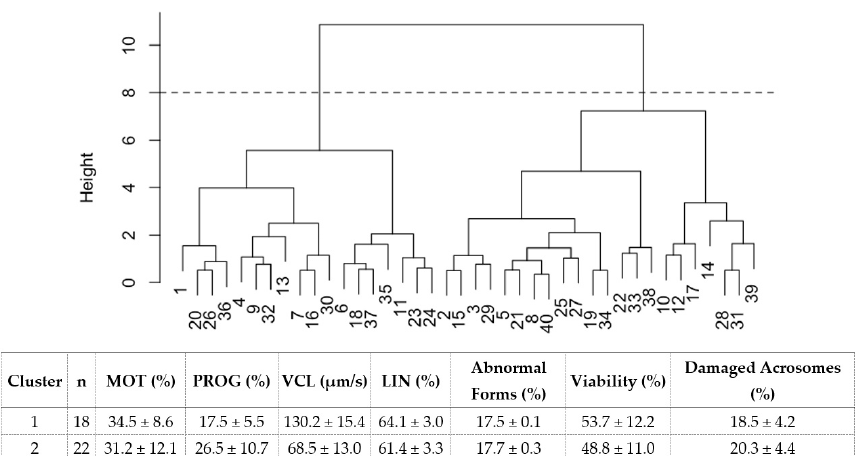
Figure 2. Clustering of the bulls (numbers) according to the post-thawing semen quality parameters. Total motility, VCL, STR, and viability were selected as the most informative and uncorrelated variables for the clustering. The table shows medians ± MAD (median absolute deviation) for each group.